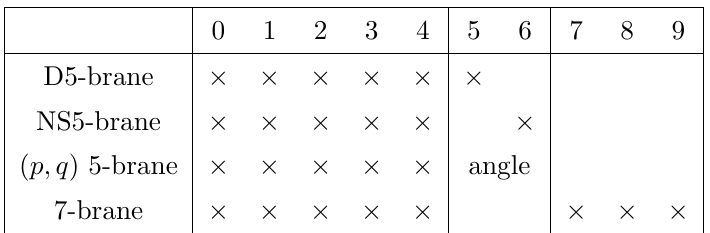
Table 1 . The con(cid:12)guration of 5-branes in the ten-dimensional spacetime of type IIB string theory. The slope of the ( p; q ) 5-brane is q in the two-dimensional ( x 5 ; x 6 )-space. In particular, p a horizontal line represents a horizontal line and a vertical line represents an NS5-brane. Since the structure of the 5-brane only appears in the ( x 5 ; x 6 )-plane, we only write the two-dimensional plane for depicting a